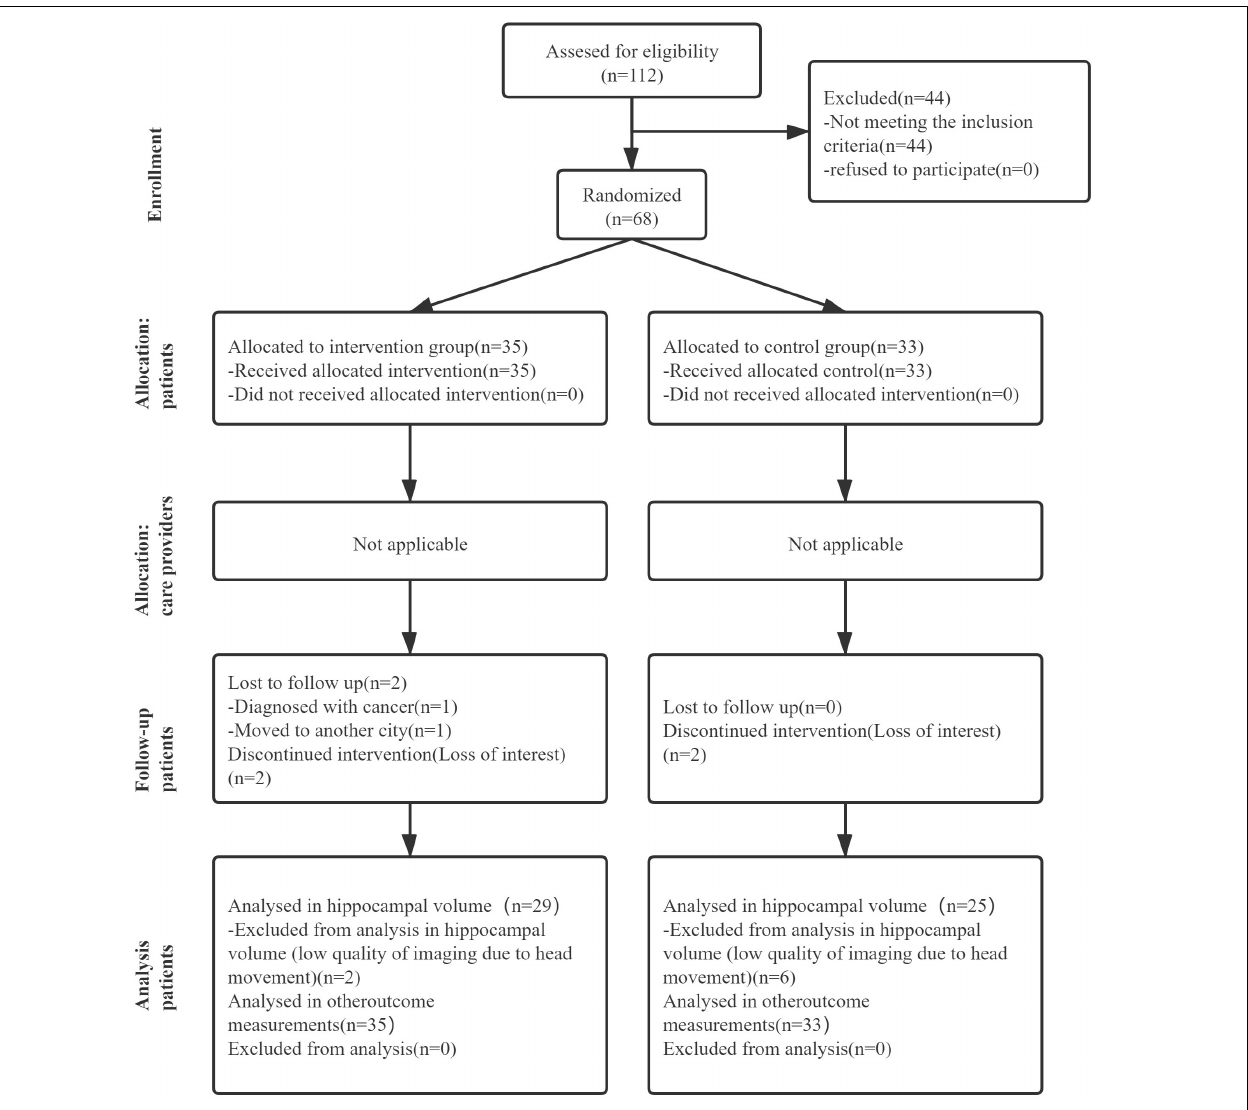
FIGURE 1 | The flow diagram of the research, showing the experimental process of this article which includes recruitment process, grouping process, and subsequent data